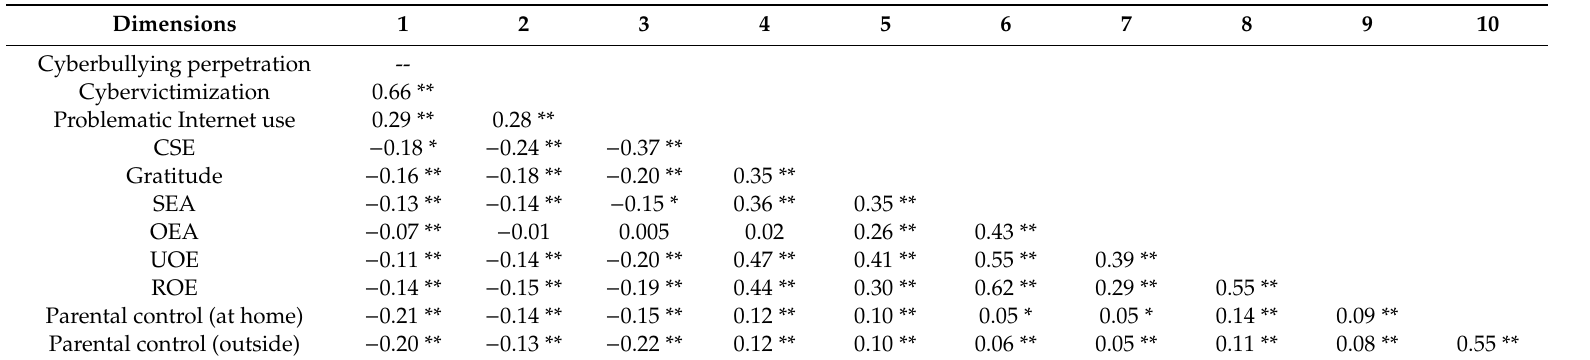
Table 2. Correlation coe ffi cients of the variables in